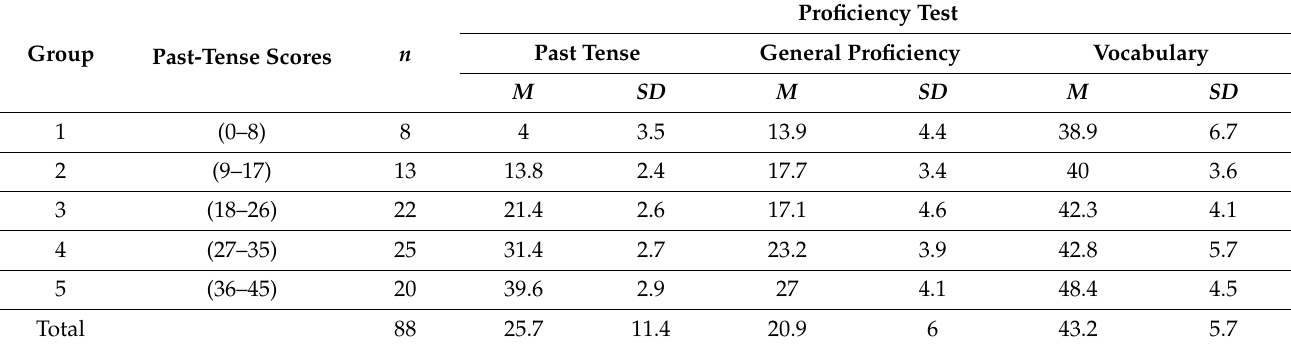
Table 1. Past-tense proficiency